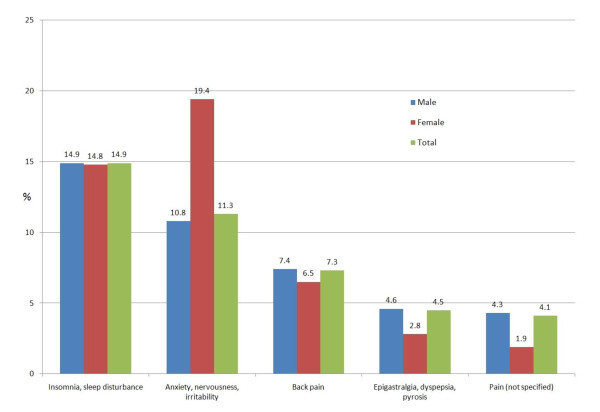
Symptoms coded without precise diagnosis (42.2%, 95%CI 40.1-44.3)